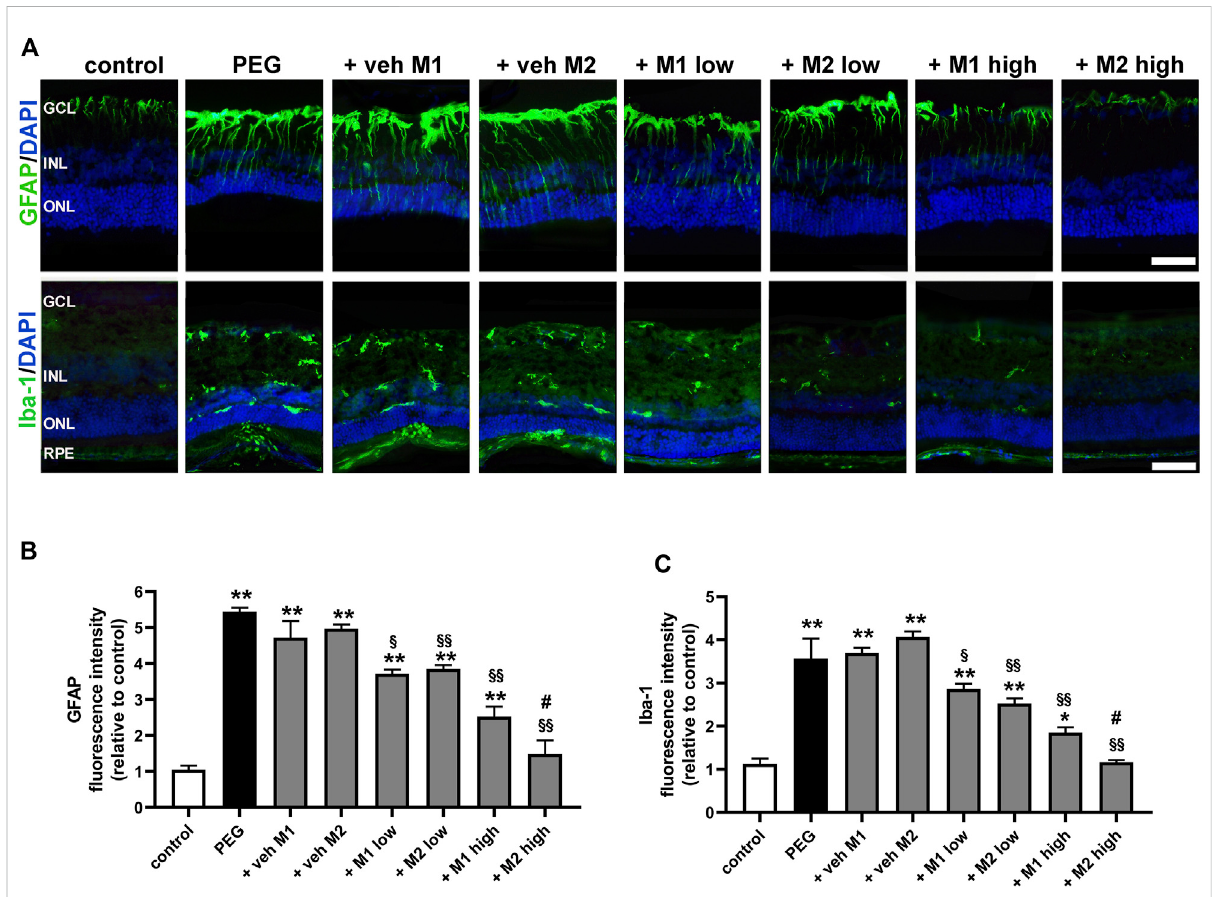
FIGURE 4 Effect of M1 and M2 on Müller cells gliosis and microglial reactivity in the site of lesion. (A) Representative images of retinal cross sections immunolabeledforGFAPorIba1incontrols, PEG-injecteduntreated,PEG-injectedtreatedwithM1orM2vehicles,PEG-injectedtreatedwithlowor high dose of M1 as well as with low or high-doseof M2. Scale bar, 50 μ m. GCL, ganglion cell layer;INL, inner nuclear layer; ONL, outer nuclear layer; RPE, retinal pigment epithelium. Quantitative analysis of GFAP (B) and Iba1 (C) immuno fl uorescence intensity. Data are plotted as mean ±